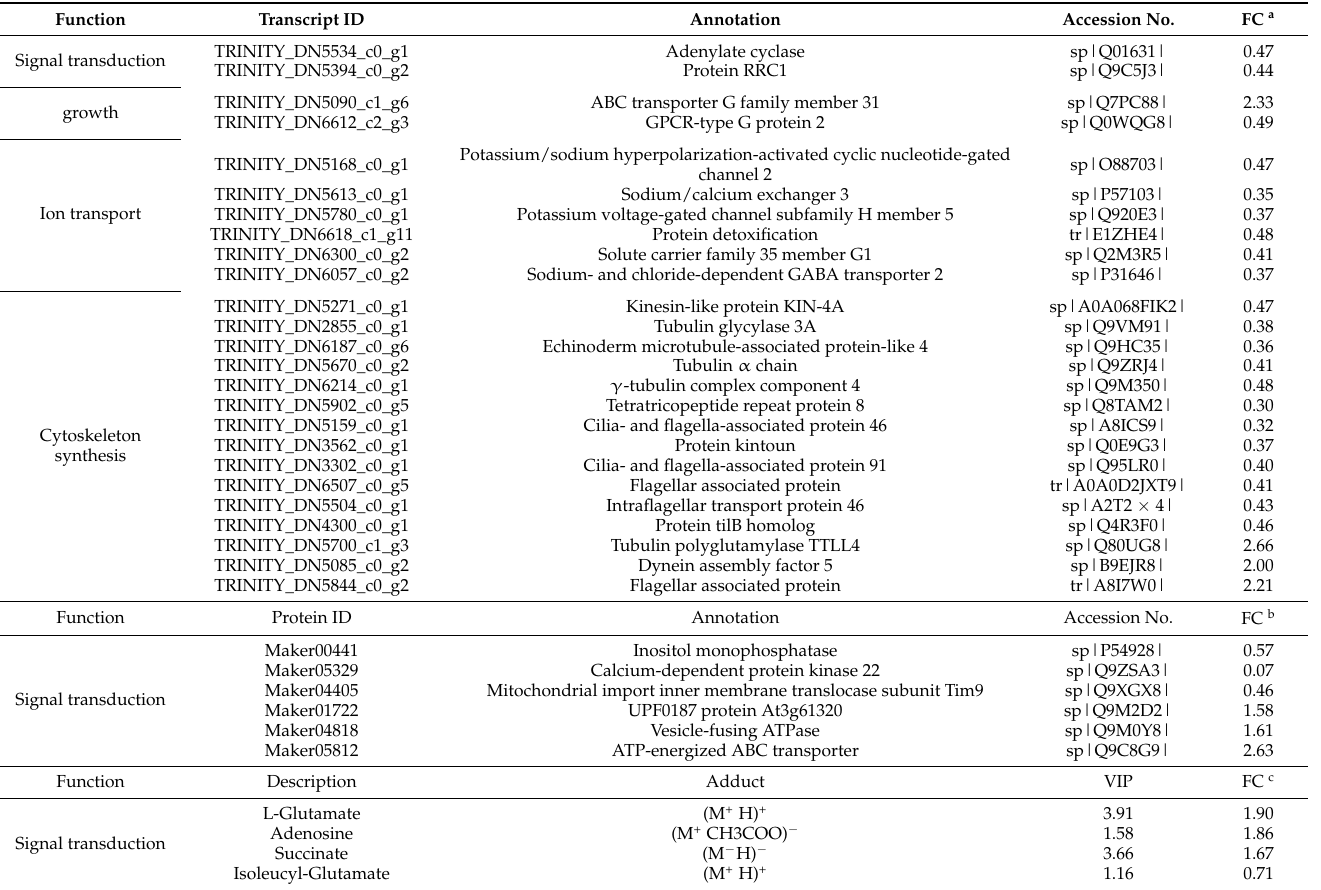
Table 4. Fluctuation of molecules in U. prolifera on cell signal transduction and growth after 12 h treatment with high